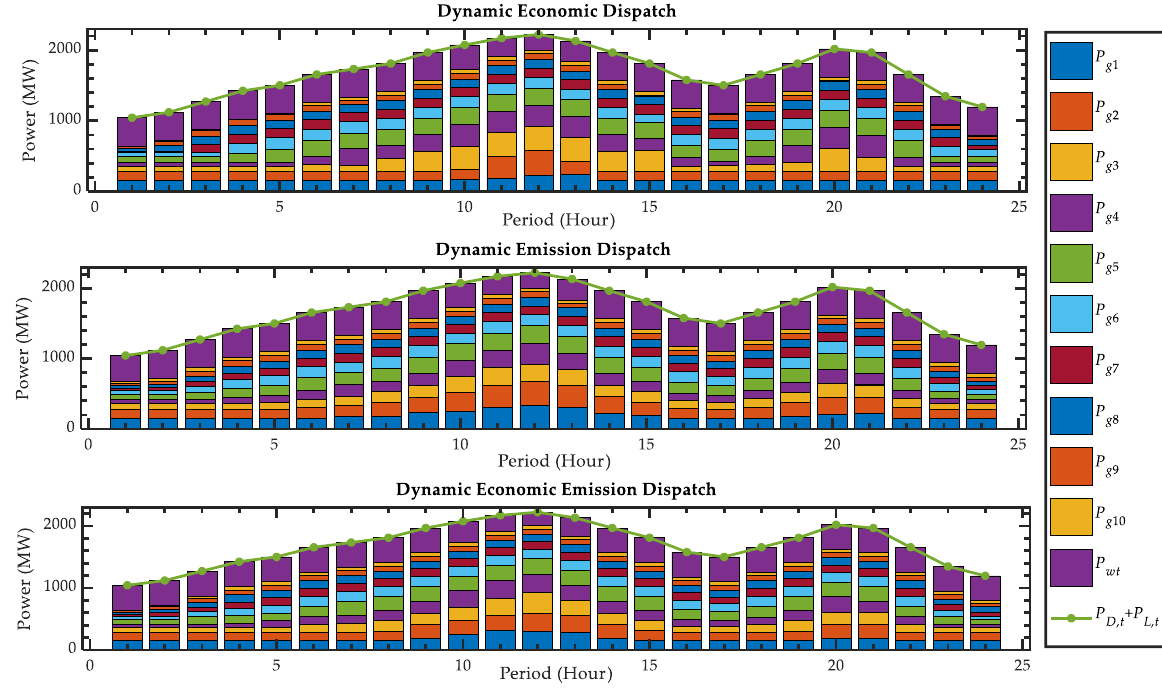
Figure 8. Optimal schedule of thermal units and WP source for case 4.